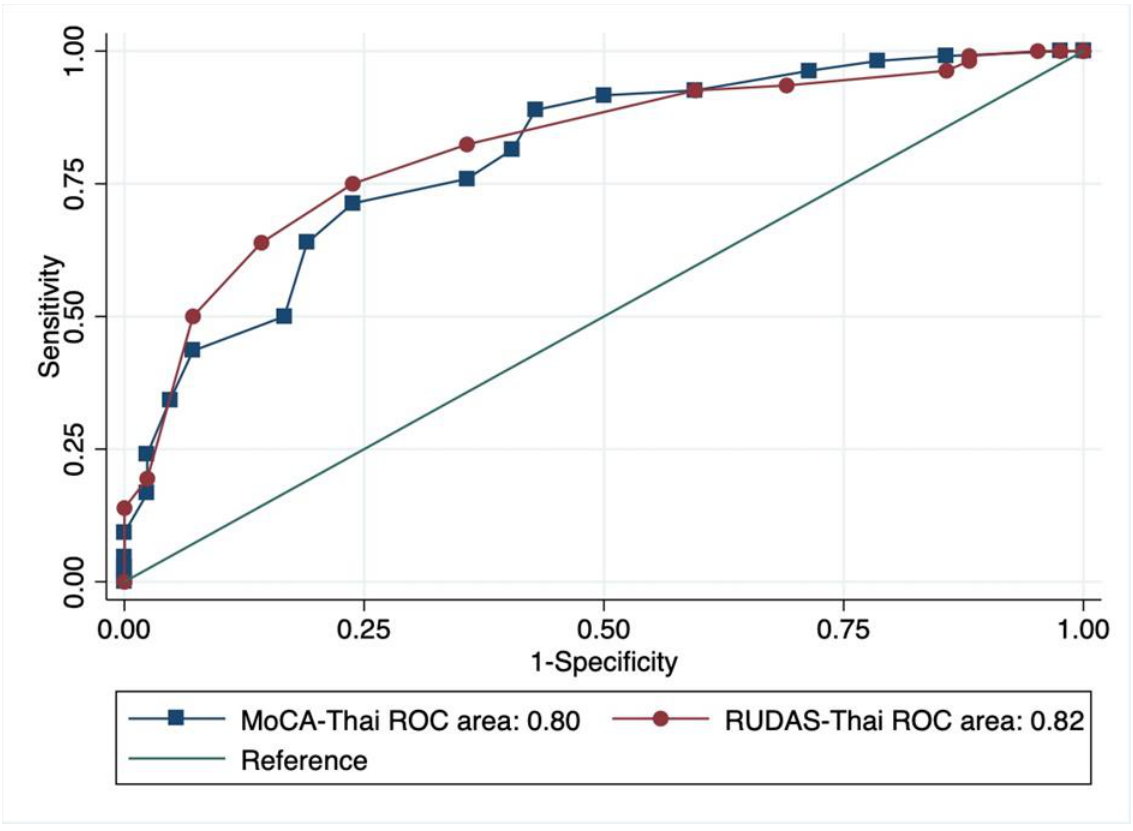
Figure 3. Comparison of the overall performance of the RUDAS-Thai and the MoCA-Thai using ROC curve. Table 2. The RUDAS-Thai performance on screening for MCI at different cut-off points. Table 3. The MoCA-Thai performance on screening for MCI at different cut-off points. Cutoff Points